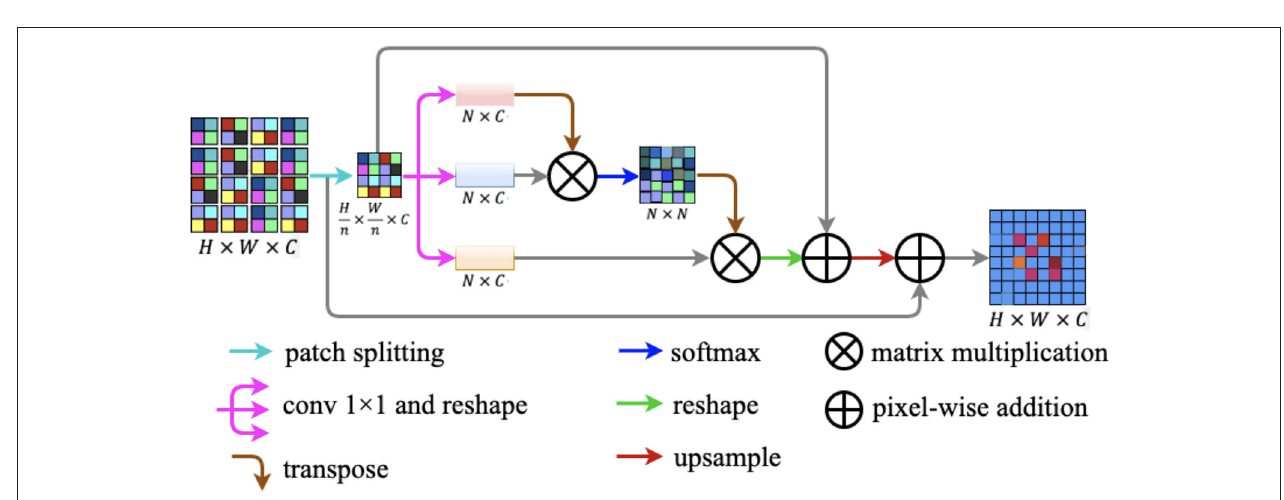
FIGURE 7 | Patch attention module. It consists of two modules: a patch splitting module and an attention module.